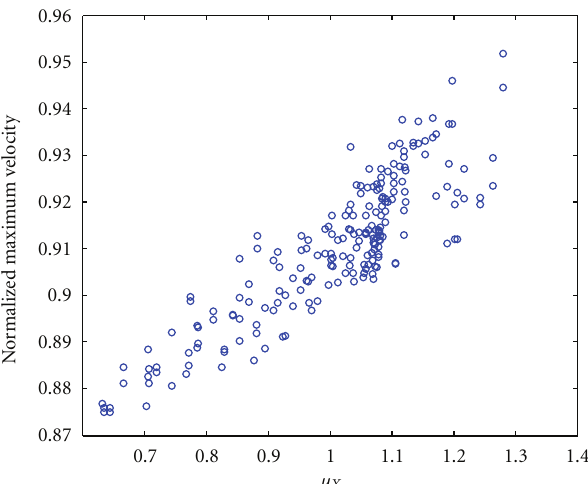
Figure 23: Scatter diagram of DSI μ X versus velocity along the X direction (horizontal half-plane XY with Z = − 900mm).